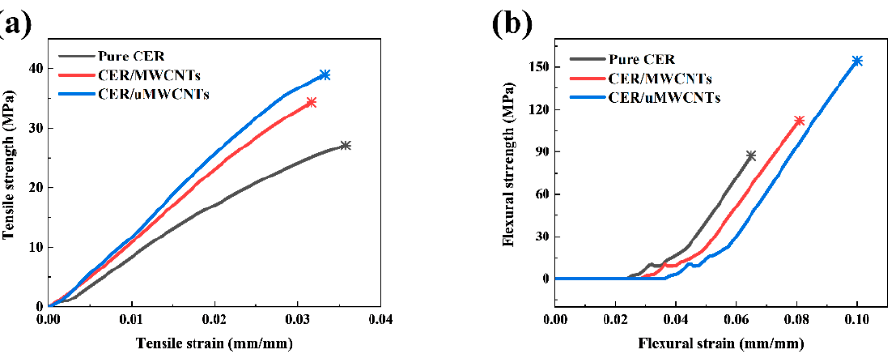
Figure 6. The mechanical properties of pure CER network, CER/MWCNTs and CER/uMWCNTs nanocomposites.